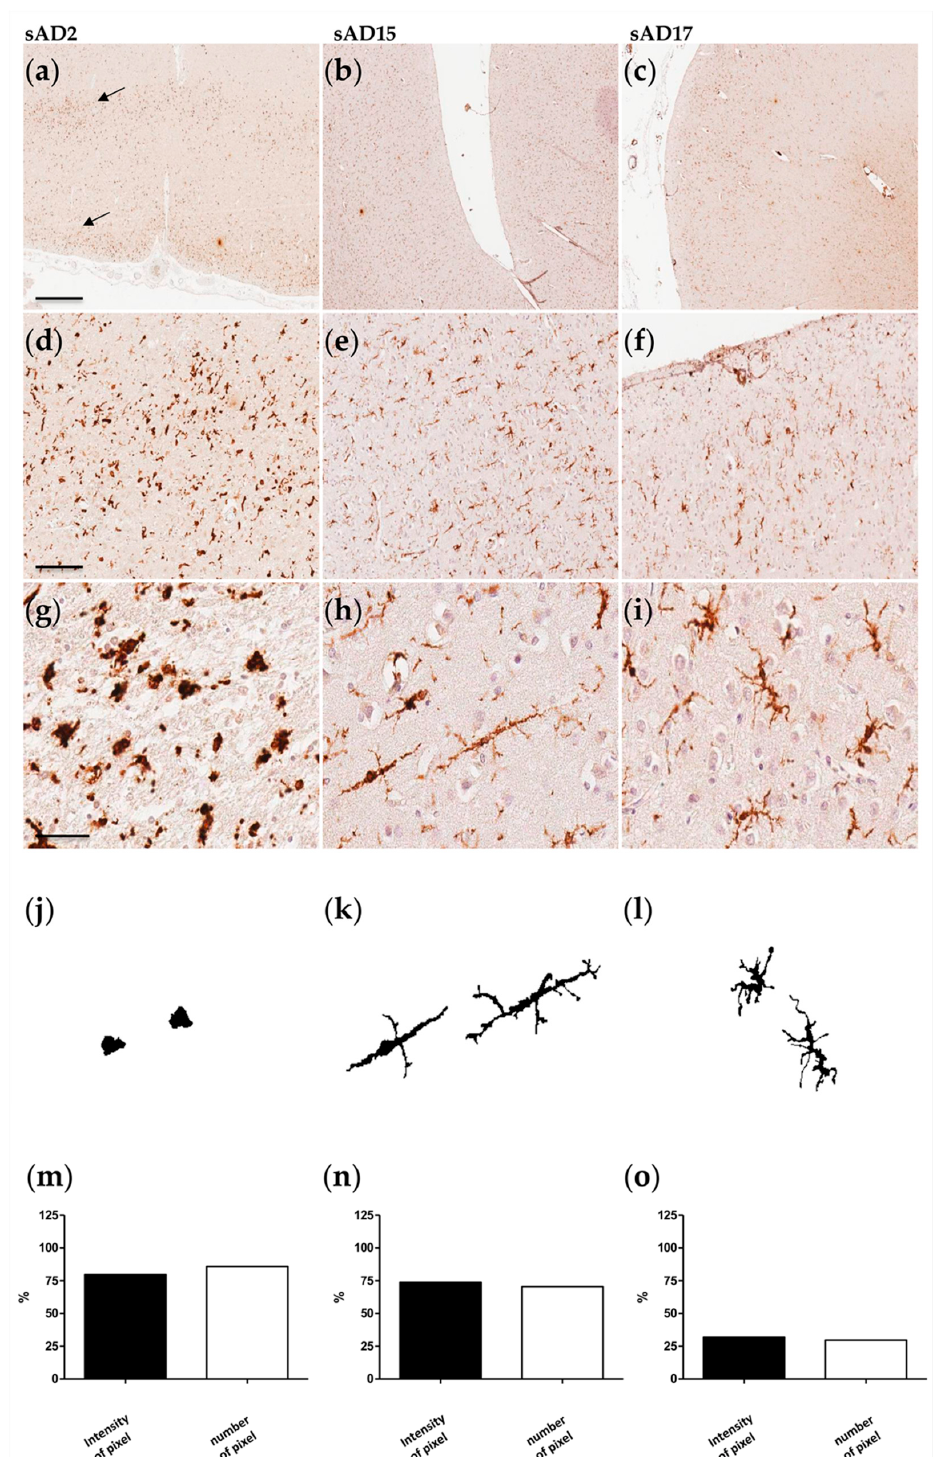
Figure 2. Microglial characterization in sAD cases. ( a , d , g , j , m ) sAD6; ( b , e , h , k , n ) sAD19; ( c , f , i , l , o ) sAD21. Scale bar 1 mm ( a – c ) 200 μ m ( d – f ); 50 μ m ( g – i ). ( a – i ) Frontal cortex sections immunostained with the IBA1 antibody. Arrows in (a) highlight the bilayer distribution of microglial cells across the frontal cortex. ( j – l ) Morphological shape extracted and edited by imageJ software analysis. ( m – o ) Quantification of IBA1 immunoreactivity based on the intensity and number of pixels (data were normalized respect to the higher signal obtained among AD samples).